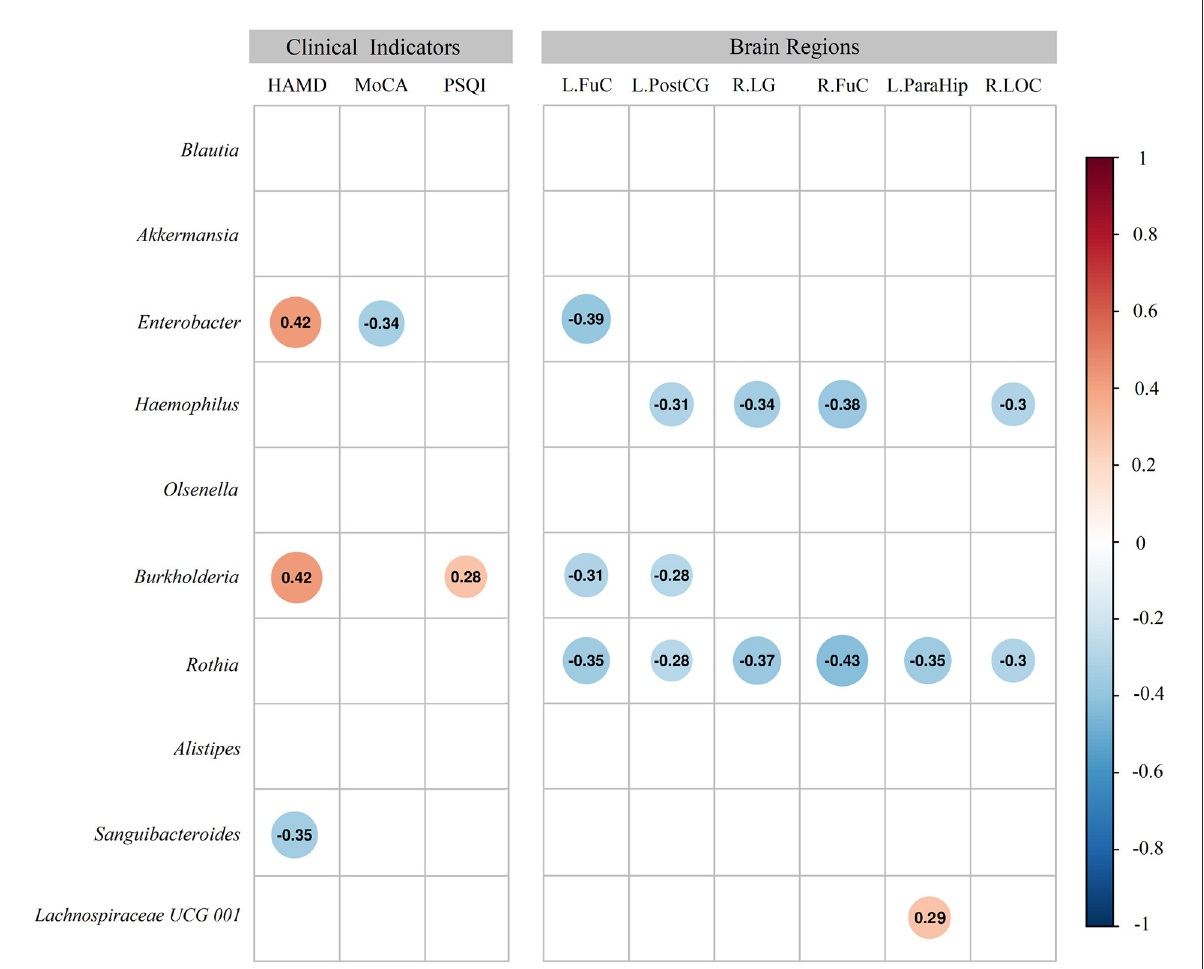
FIGURE5 Heatmap of Spearman’s rank correlation coefficients of the relative abundances of different gut microbiota at the genus level with clinical indices and regions with brain morphometric differences. Color intensity represents the magnitude of the correlation (blue circles = negative correlations; red circles = positive